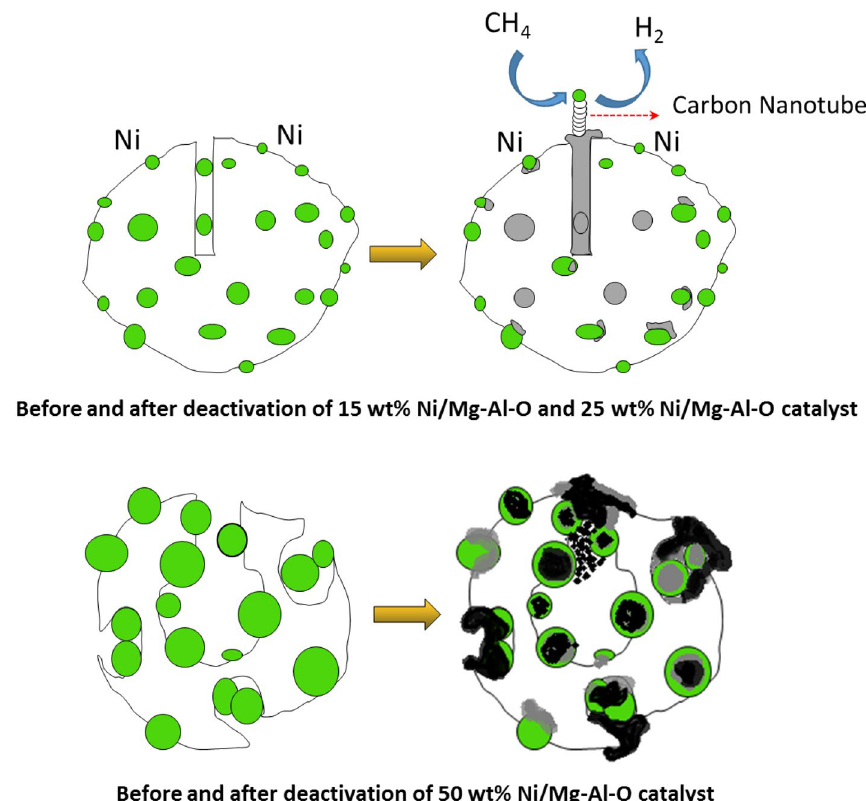
Fig. 4 Effect of loading on catalyst deactivation [80]